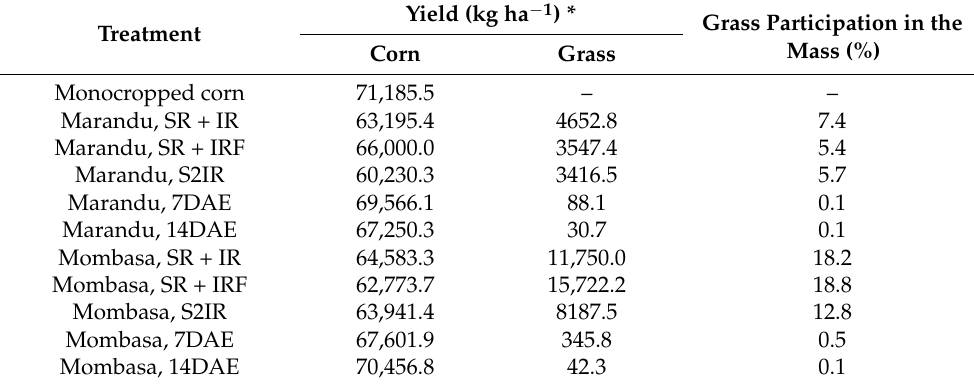
Table 1. Corn ( Zea mays L.) and grasses green mass yield and the grasses participation in the total biomass of corn and grass intercropping under different sowing